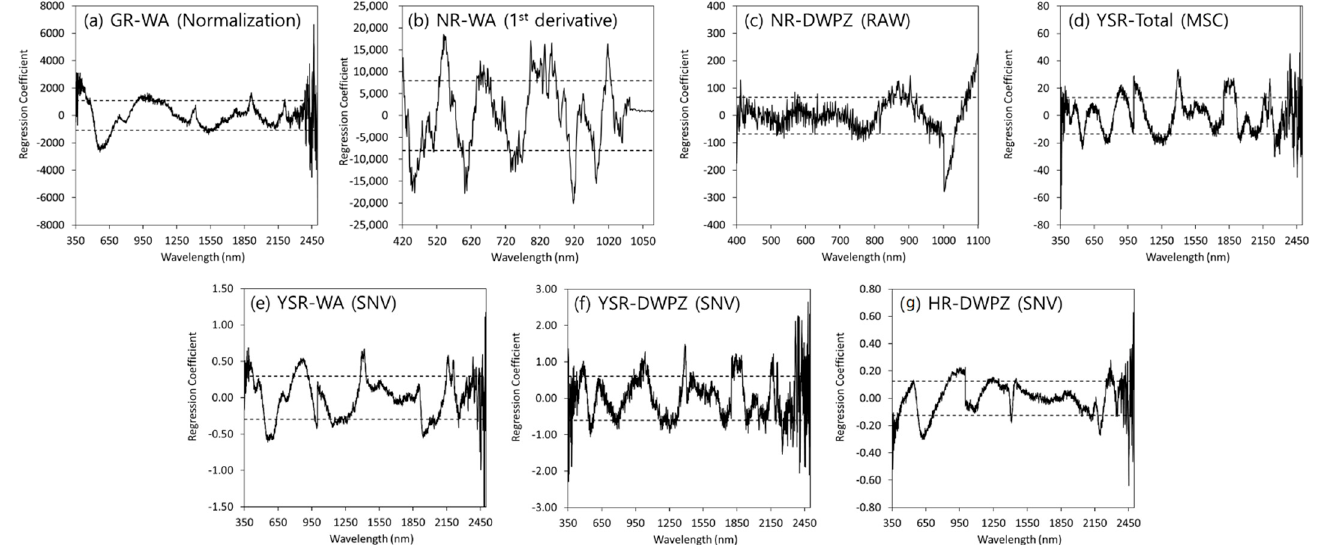
Figure 5. Plots of the regression coefficient with the PLSR models for SOM predictions in ( a ) WA of GR, ( b ) WA of NR, ( c ) DWPZ of NR, ( d ) total of YSR, ( e ) WA of YSR, ( f ) DWPZ of YSR, and ( g ) DWPZ of